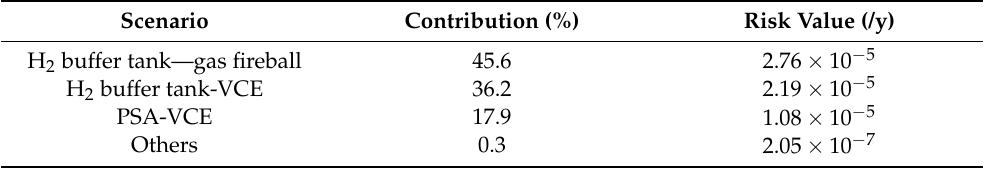
Figure 6. The change in overpressure with respect to distance for ( a ) the FAHRS VCE scenario due to the rupture of the H 2 buffer tank and ( b ) the GHRS VCE scenario due to the rupture of the H 2 tube trailer. The affected distance for the overpressure level of 137.9 mbar (yellow contour in Figure 5) is shown for both cases. Table 5. The societal risk values with respect to the scenarios for the FAHRS